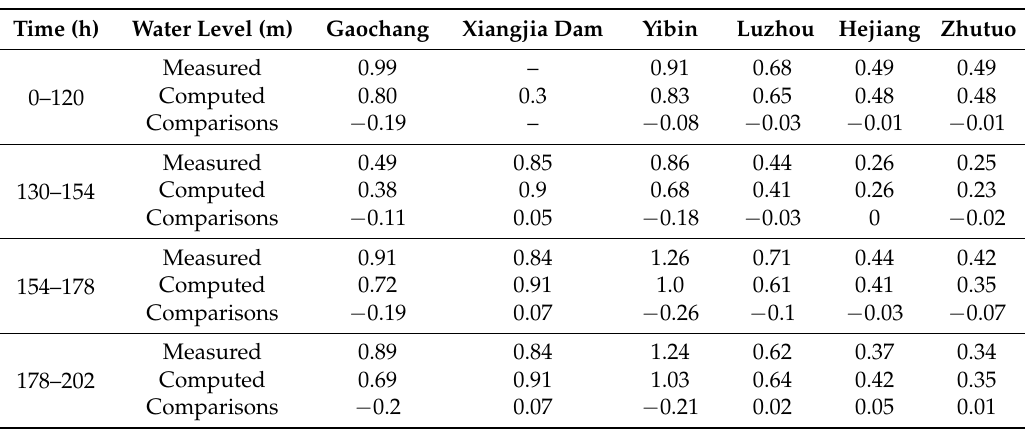
Table 2. Flood wave height and comparisons on 22–26 February and 26 February–3 March 2013.